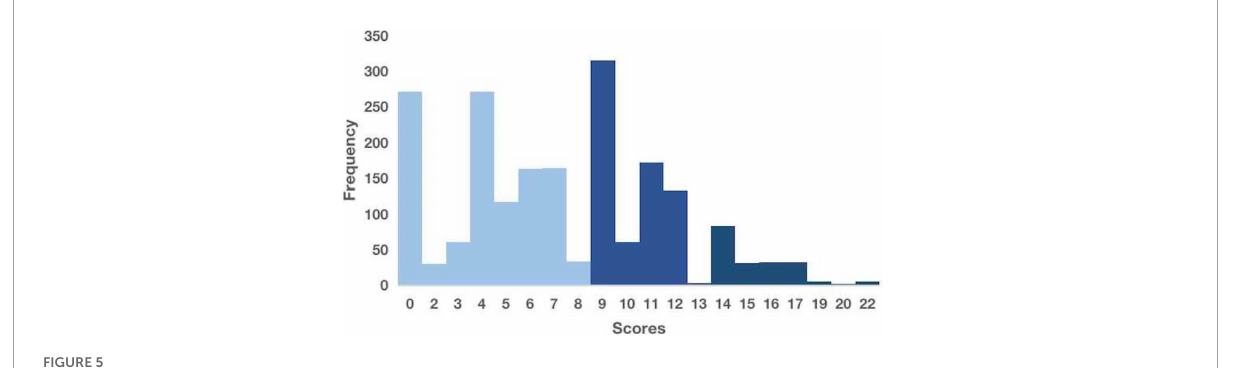
FIGURE5 Distribution of scores for our patients.